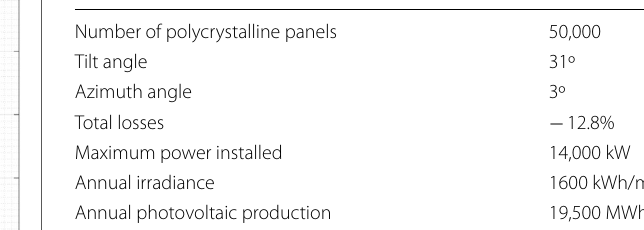
Table 13 Faial system design data with polycrystalline photovoltaic panels